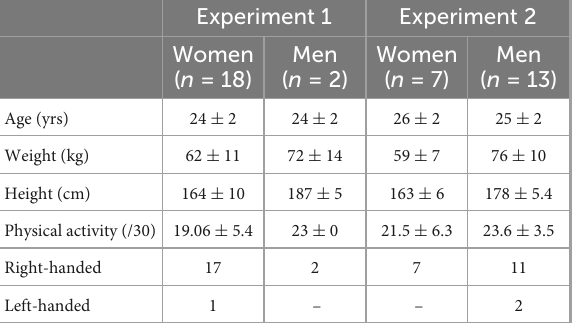
TABLE 1 Description of